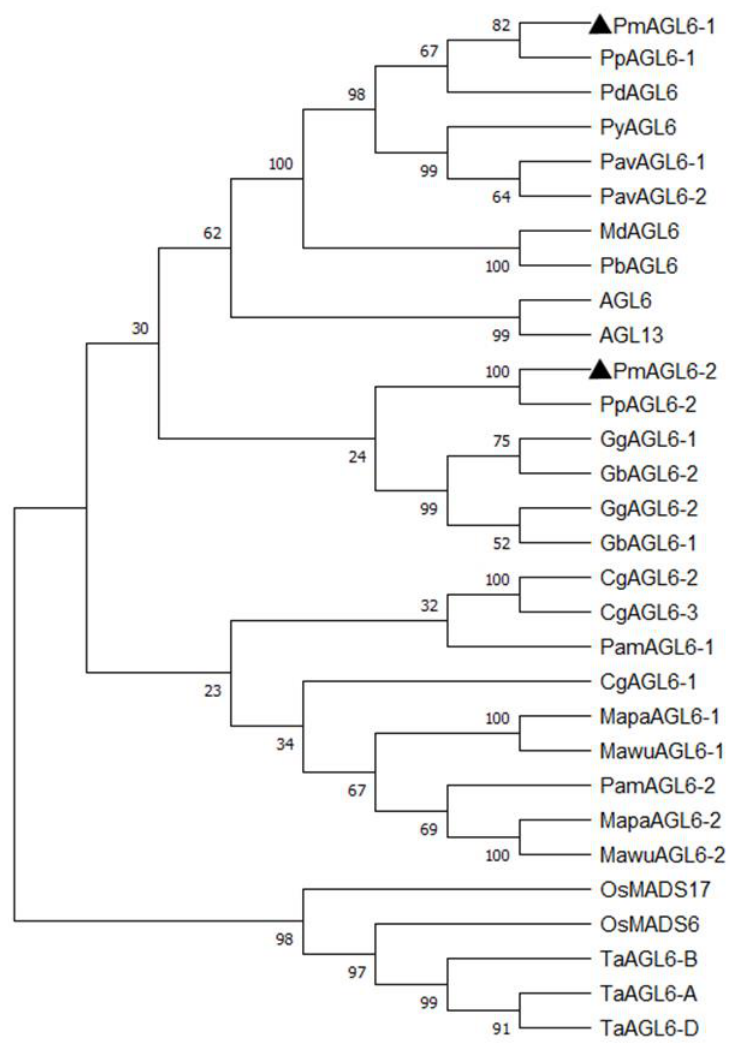
Figure 2. Phylogenetic analysis of AGL6 proteins. The tree was constructed via the neighbor-joining method using MEGA5-X software with a bootstrap analysis of 1000 replicates. The accession numbers of the other proteins included in the phylogenetic analysis are as follows: PpAGL6-1 ( Prunus persica , XP_020412713.1), PpAGL6-2 ( Prunus persica , XP_007220094), PdAGL6 ( Prunus dulcis ,